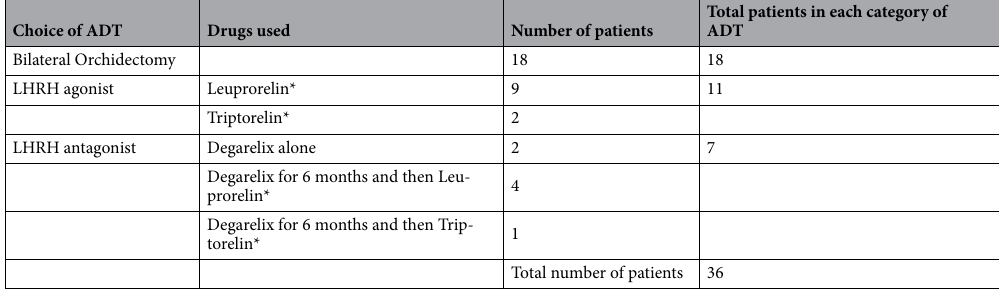
Table 1. The choice of androgen deprivation therapy for the 36 patients. ADT Androgen deprivation therapy, LHRH agonist luterizing hormone releasing hormone agonist, LHRH antagonist luterizing hormone releasing hormone antagonist. All LHRH agonist used were 3-monthly formulation. * P <